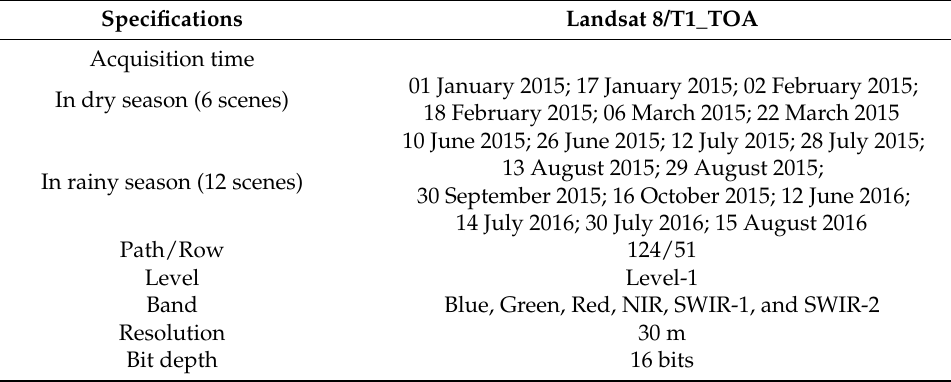
Table 1. Landsat 8 images used in this